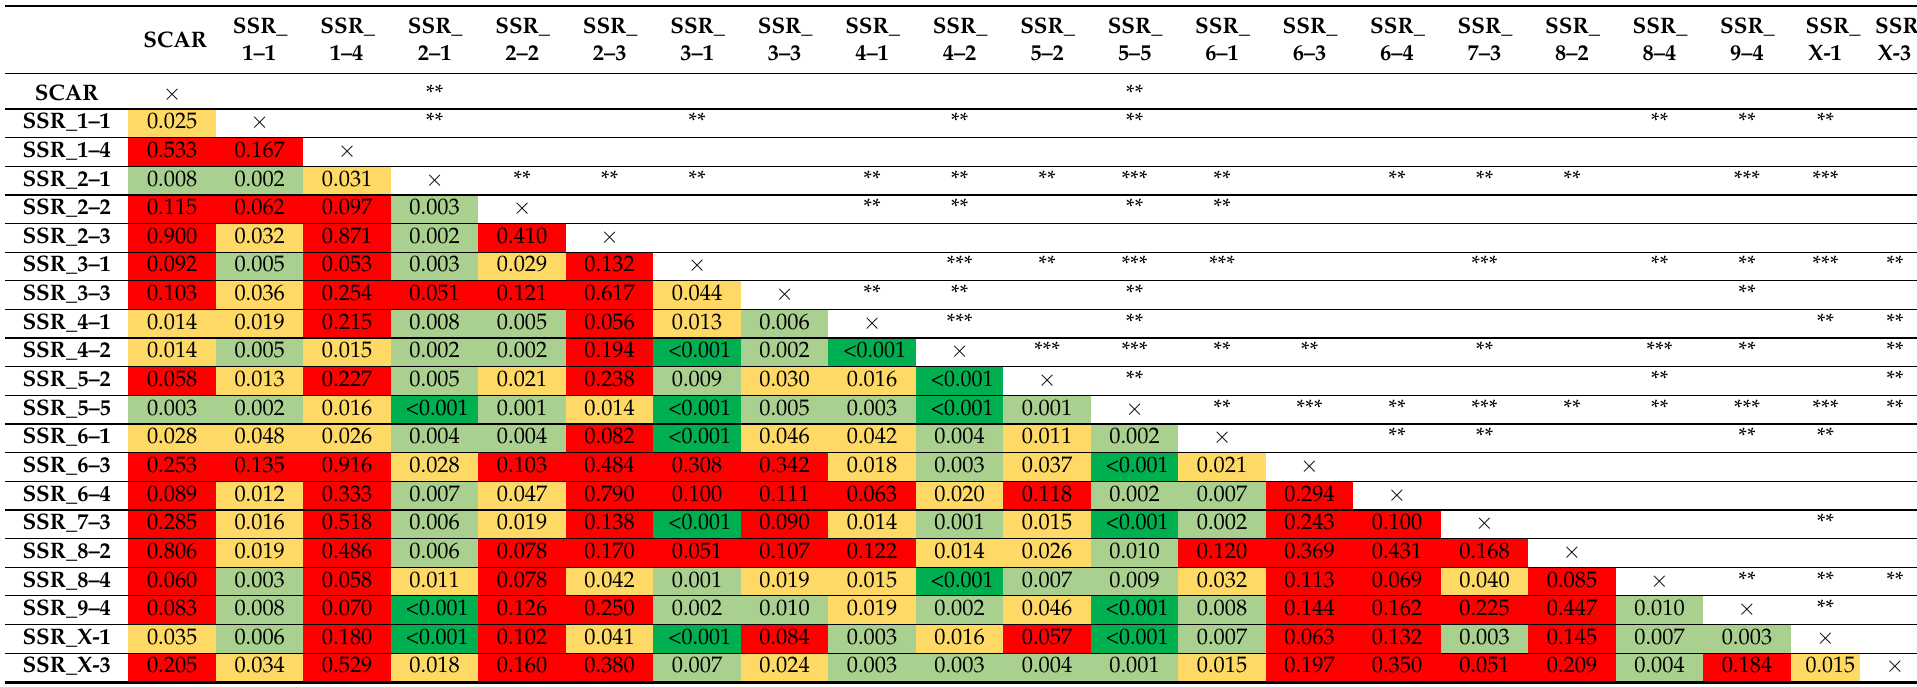
Table 3. Pairwise linkage disequilibria (LD) between all SSR marker loci and the SCAR119 marker. Significant LD **: 0.001 < p <0.01 ***: p <